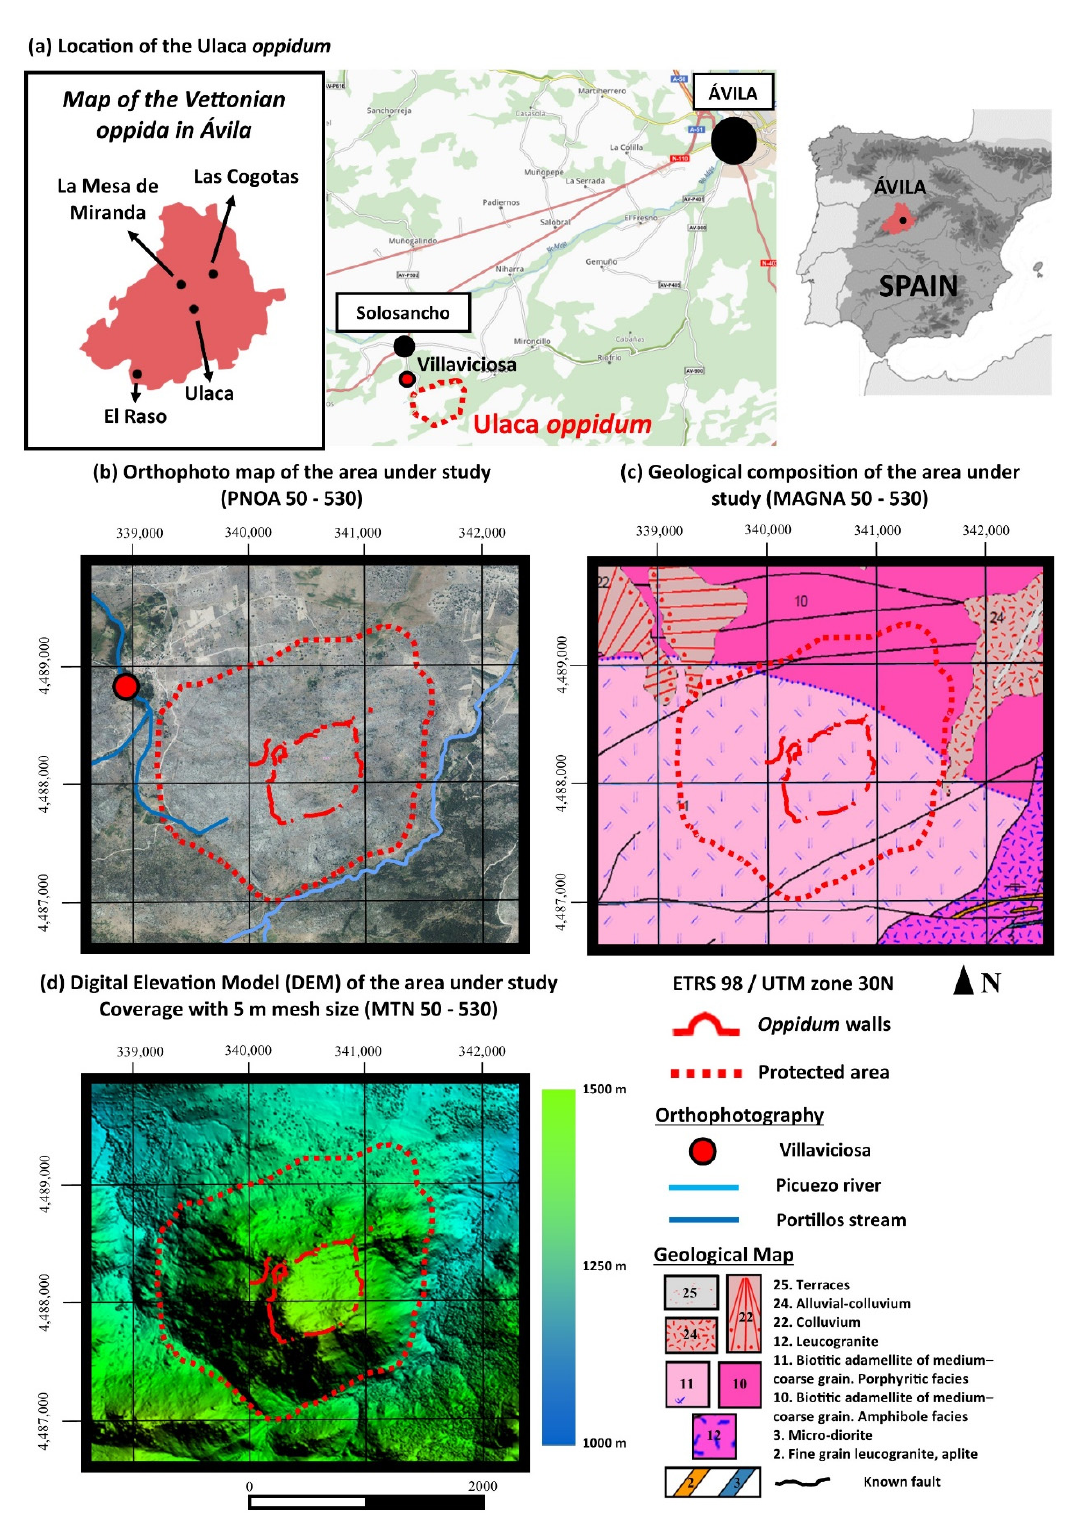
Figure 1. Location and geology of the Ulaca oppidum (Villaviciosa, Solosancho, Ávila, Spain). The Ulaca oppidum is located close to the village of Villaviciosa (Solosancho, Province of Ávila, Spain) (Figure 1a). This site was occupied towards the end of the Iron Age (ca. 300–50 BCE) by a community of Vettones of around 1500 inhabitants, becoming one of the largest fortified settlements in the Iberian Peninsula [56]. The creation of this urban nucleus converted this site into the most significant town of the Amblés Valley, where two